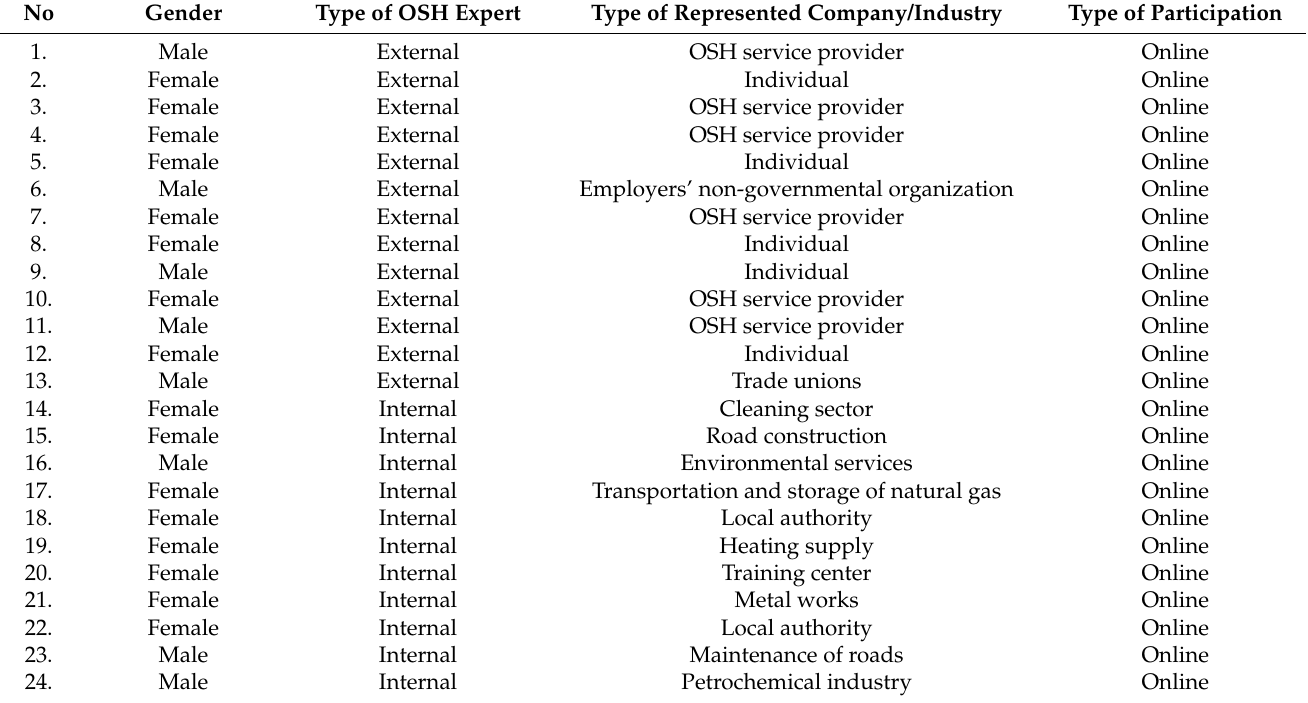
Table A4. Characteristics of the focus group participants—OSH experts and type of their